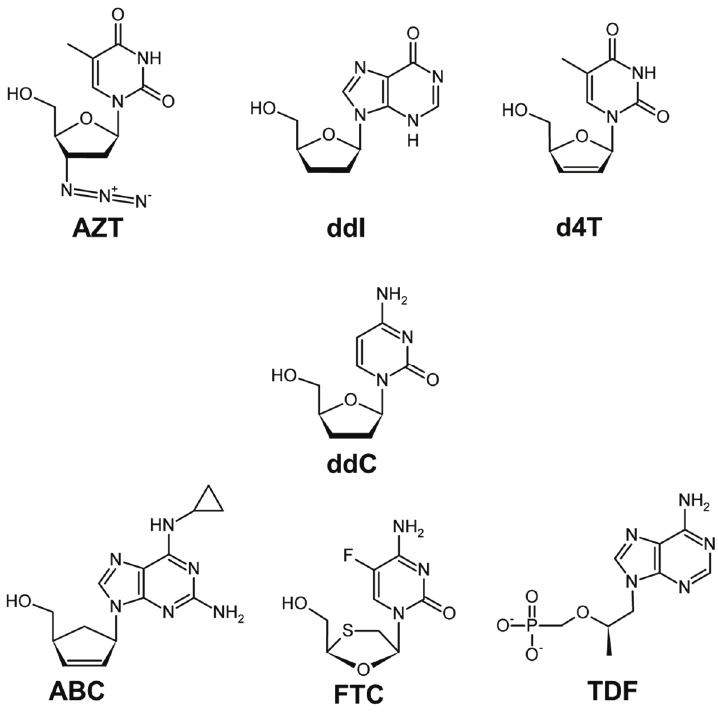
Figure 2. FDA approved nucleoside/nucleotide inhibitors (NRTIs/NtRTIs) of HIV-1B RT: All approved NRTIs/NtRTIs (AZT, azidothymidine; d4T, stavudine; FTC, emtricitabine; ddC, zalcitabine; ddI, didanosine; ABC, abacavir; TDF, tenofovir) lack a 3'-OH group. After incorporation of NRTIs/NtRTIs into DNA by HIV-1B RT, they act as chain